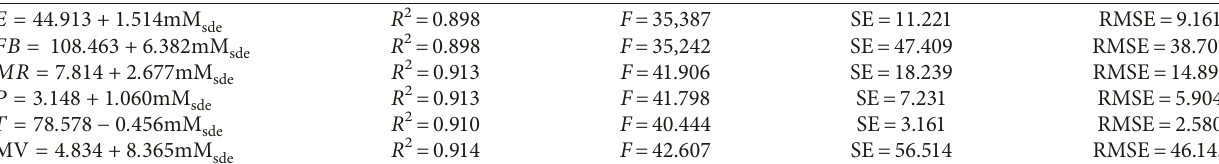
Table 5: Linear regression models that give the best estimate for physicochemical properties.